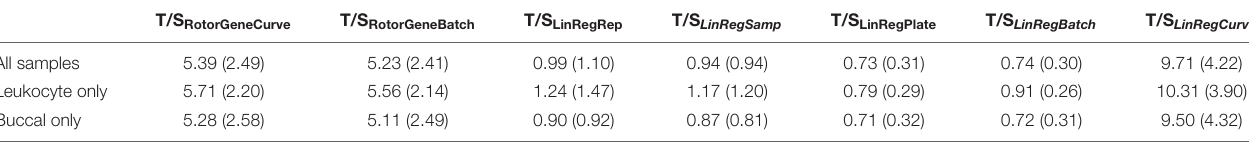
TABLE 3 | T/S ratios calculated using different amplification efficiencies.